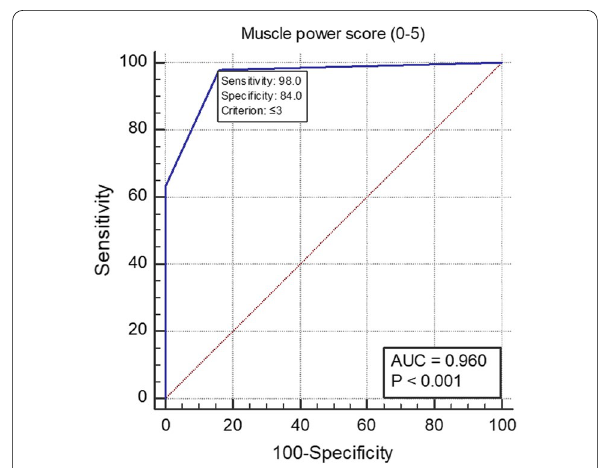
Fig. 7 Muscle power score (0–5)